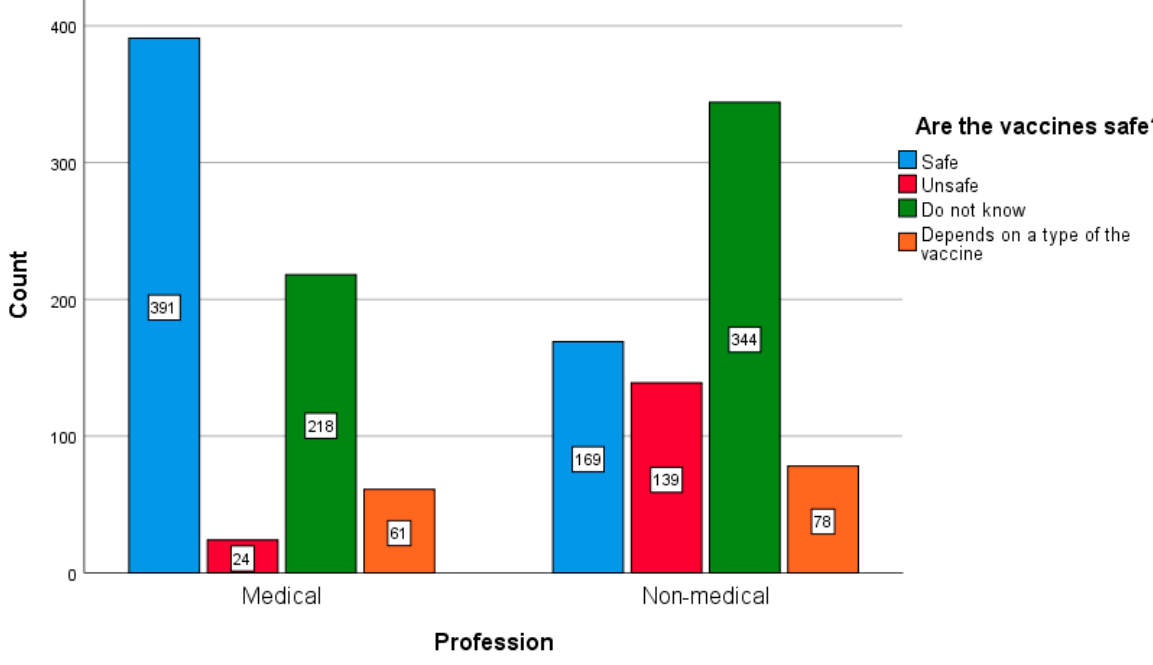
Figure 7. Beliefs about the safety of the COVID-19 vaccination among representatives of medical and non-medical professions.